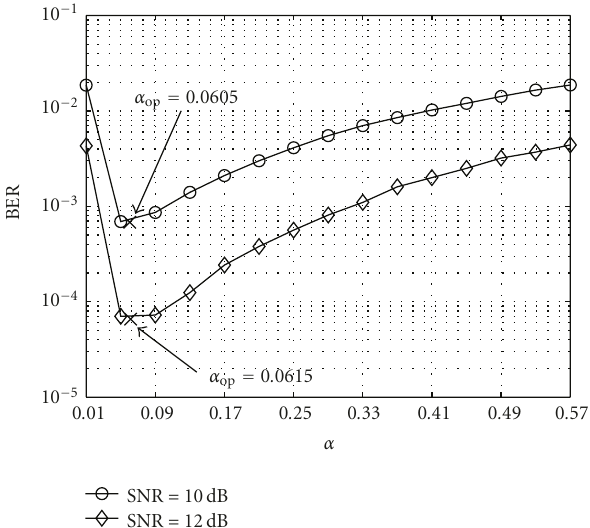
Figure 4: BER performance under di ff erent power allocation ratio (QPSK).